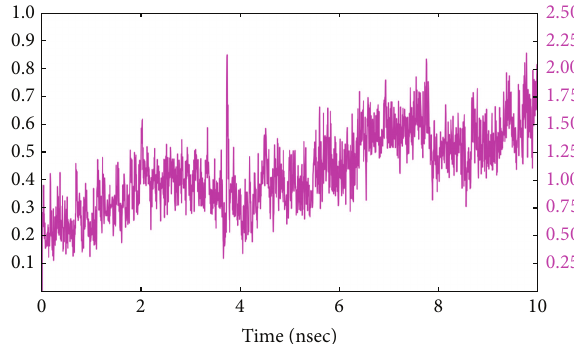
Figure 5: Simulation analysis of NS2/NS3B protease with Ligand 19